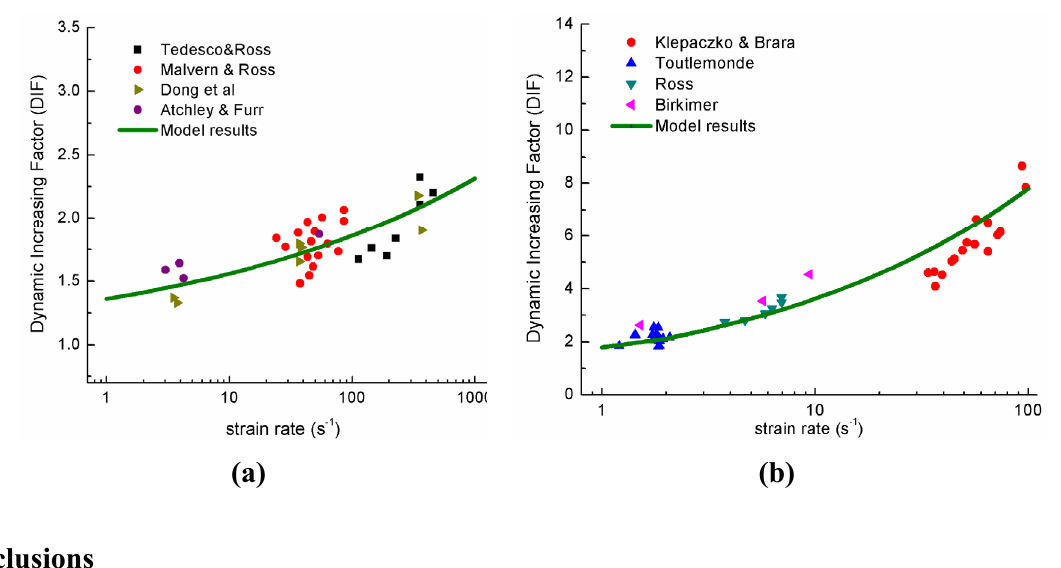
Figure 7. ( a ) Dynamic increasing factors (DIFs) under compression; and ( b ) DIFs under tension